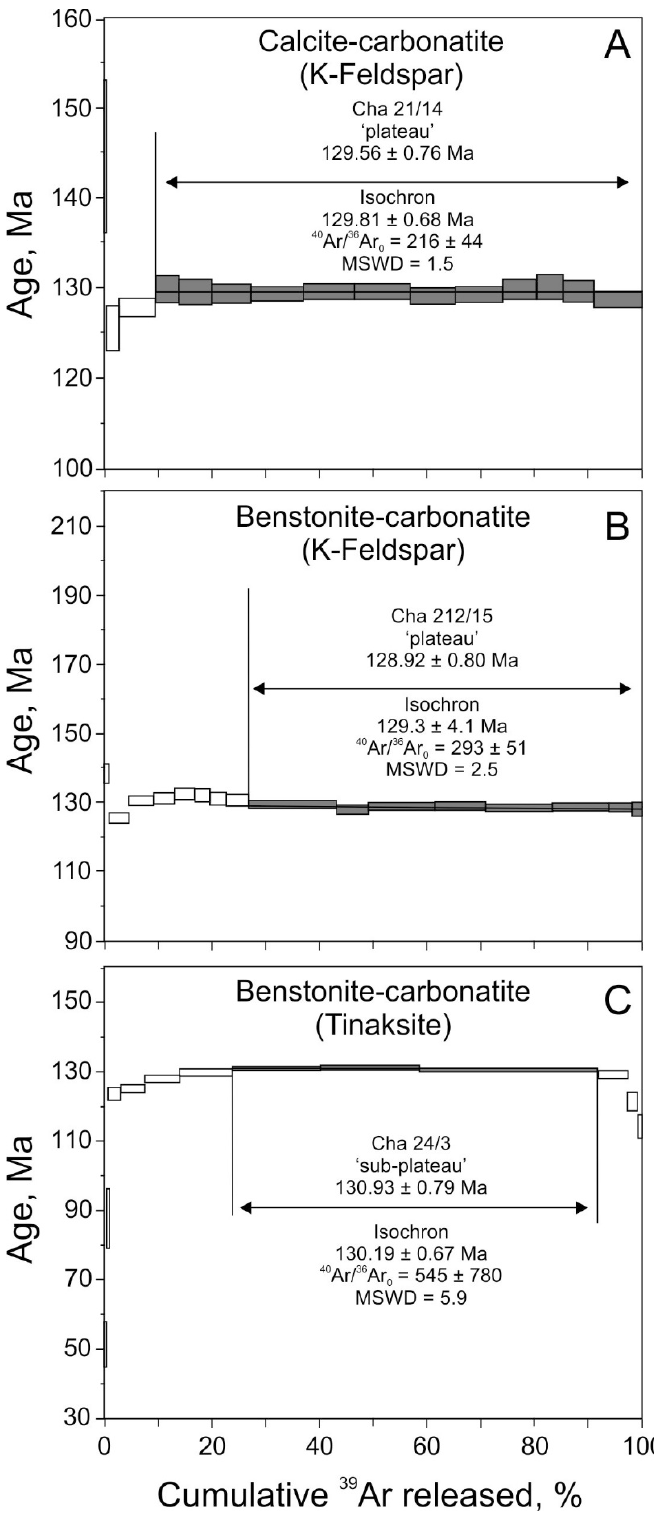
Figure 7. Argon release spectra for carbonatites of the late intrusive stage: ( A ) Sample Cha21/14—K-feldspar from calcite carbonatite; ( B ) sample Cha212/15—K-feldspar from benstonite carbonatite; and ( C ) sample Cha24/3—tinaksite (NaK 2 Ca 2 TiSi 7 O 19 (OH)) from benstonite carbonatite. Steps used for calculation of plateau, sub-plateau, and isochron age values are shadowed.